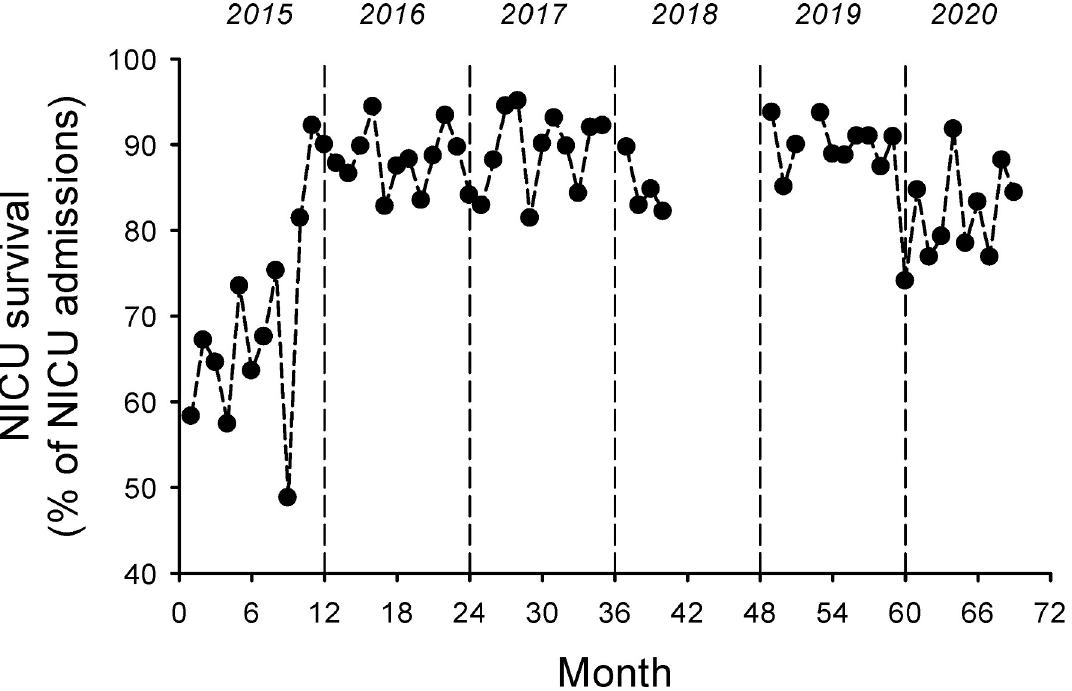
Fig 3. The implementation of the Level III NICU at GPHC was associated with an increase in the monthly survival rate for infants admitted to the NICU. The mean monthly survival rate in the first 3 quarters of 2015 was 64 ± 8% and for 2016–2020 was 87 ± 3% (p < 0.0001), grey dashed